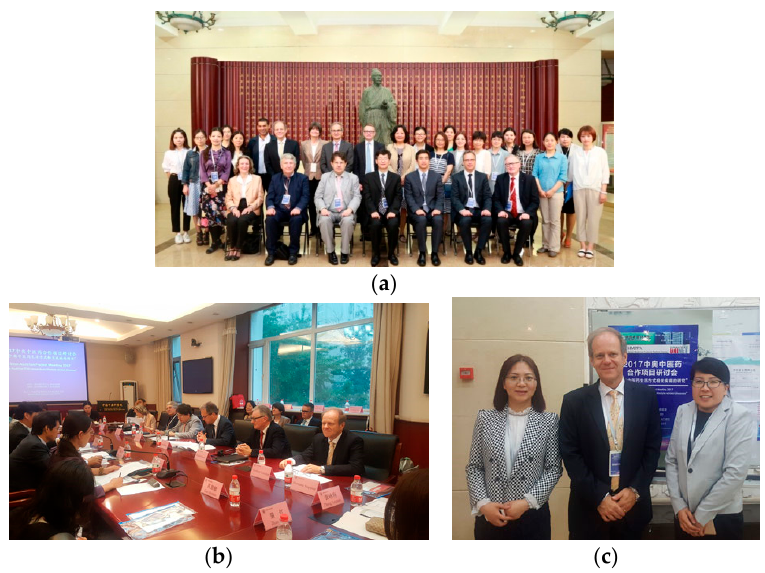
Figure 7. Sino-Austrian project meeting at China Academy of Chinese Medical Sciences, Beijing, China, 22 May 2017 ( a – c ). From left to right: Professor Gao Xinyan, Professor Gerhard Litscher, and Dr. Liu Kun ( c ).